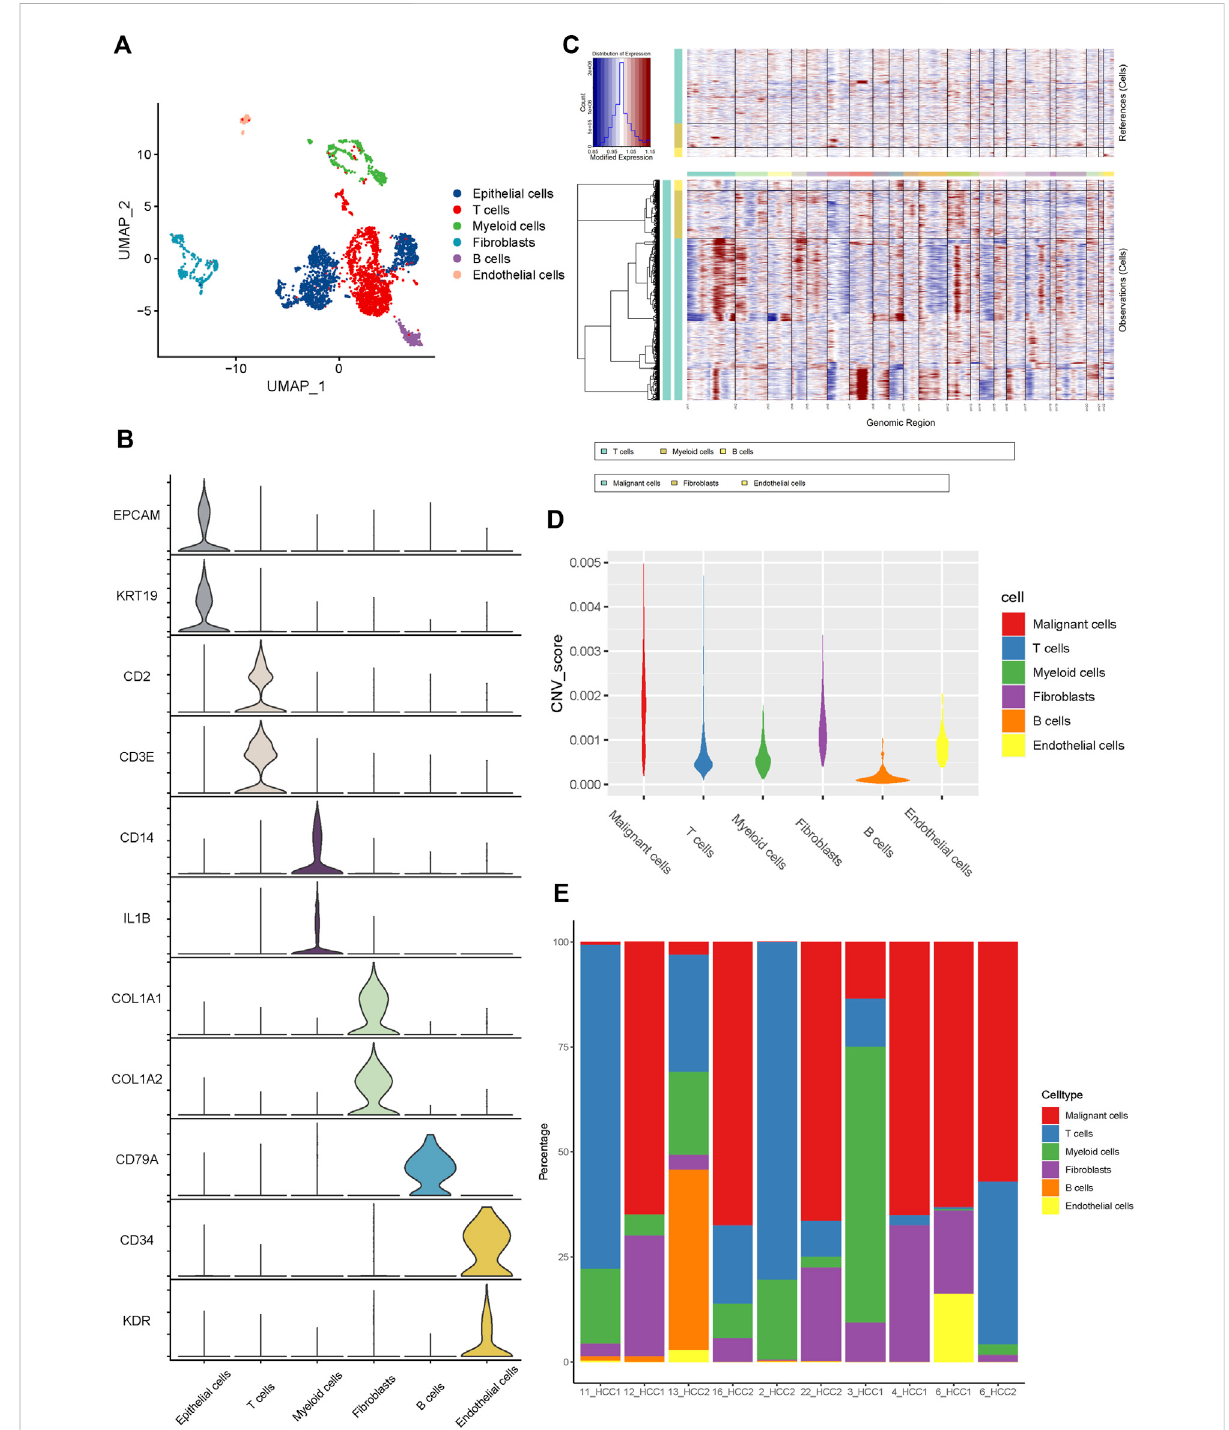
FIGURE 1 The Landscape of single-cell transcriptomic analysis of iCCA. (A) The UMAP plots of the six main cell typesfrom 10 iCCA samples. (B) The violin plots showing the expression levels of representative markers across the six main cell types. (C) The hierarchical heatmap displaying the large-scale CNVsiniCCA. (D) TheviolinplotsrevealingthedifferencesofCNVscoresamongthesixmain cellstypes iniCCA. (E) The relativepercentage ofeach cell type in 10 iCCA